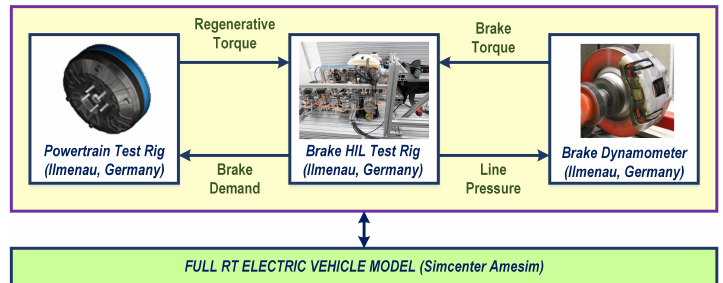
Figure 9. XILforEV configuration for brake blending studies.